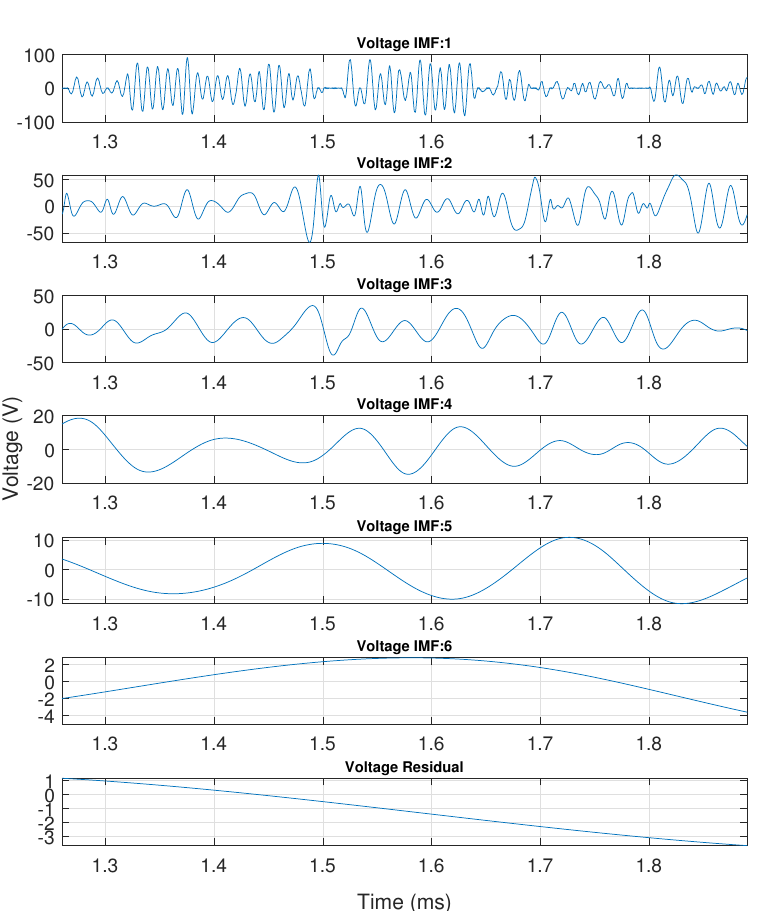
Figure 7. Target Model Voltage Intrinsic Mode Functions [28]. (© 2023 IEEE. Reprinted, with permission, from EEEIC/I&CPS